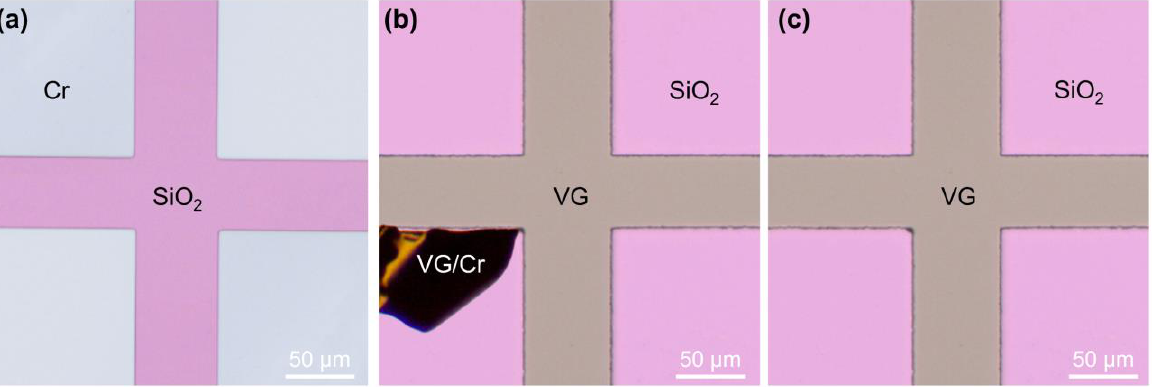
Figure 2. Microscopic images of ( a ) patterned Cr barrier layer, ( b ) warped VG/Cr debris left on the substrate, and ( c ) final patterned VG.